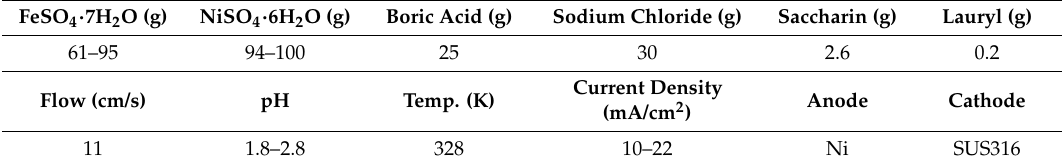
Table 1. Electroforming bath conditions and process parameters used in the current work. FeSO 4 · 7H 2 O